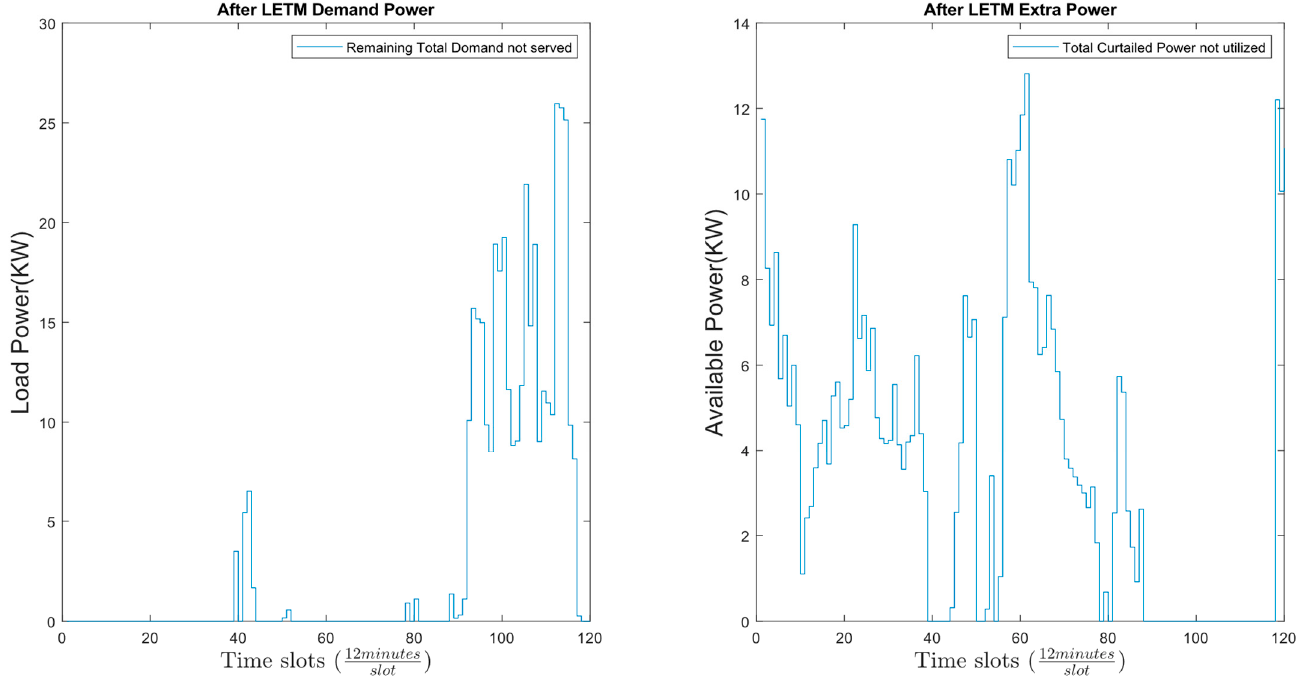
Figure 12. Power demand and surplus after LETM for unscheduled load.